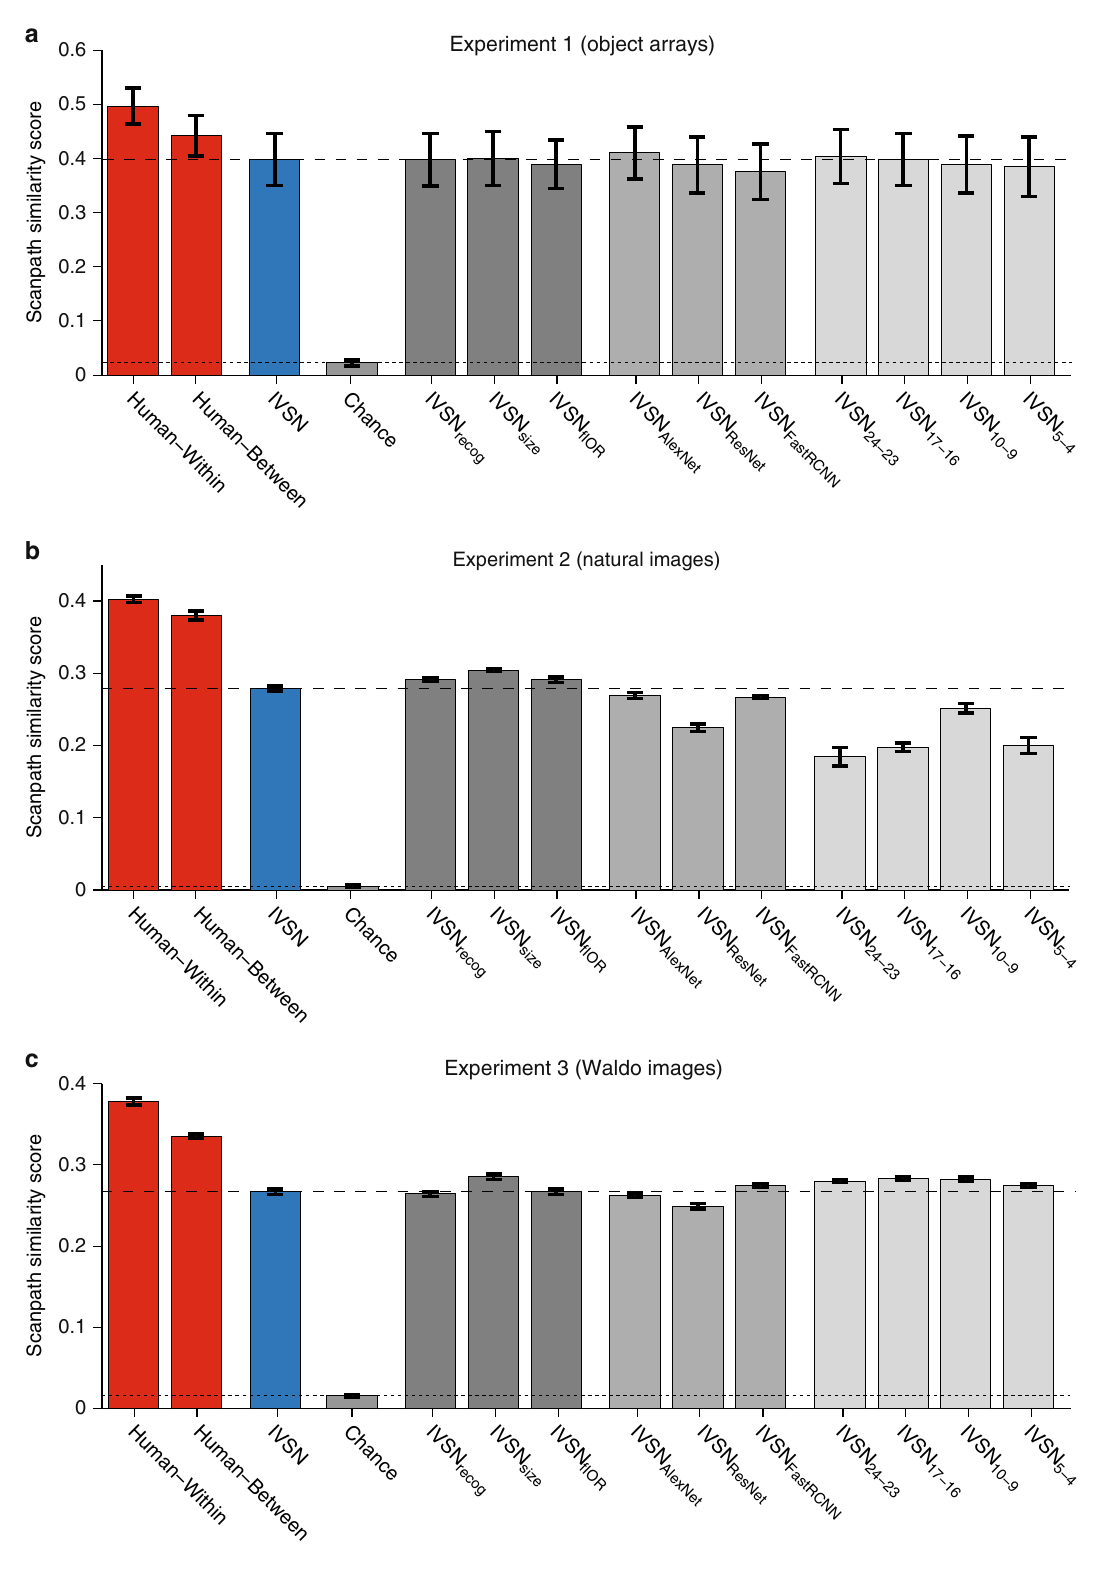
IVSN fIOR versus human performance: Experiment 1: p = 0.87; Experiment 2: p = 0.03; Experiment 3: p = 0.29; two-tailed t -tests). Another difference between humans and the model is the